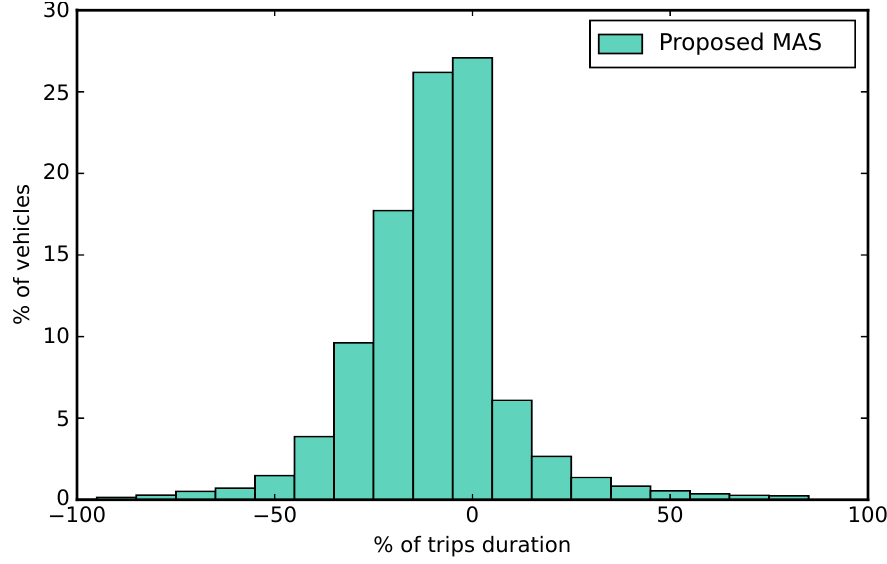
Figure 7. Percentage of increase or decrease in the trip duration over the percentage of